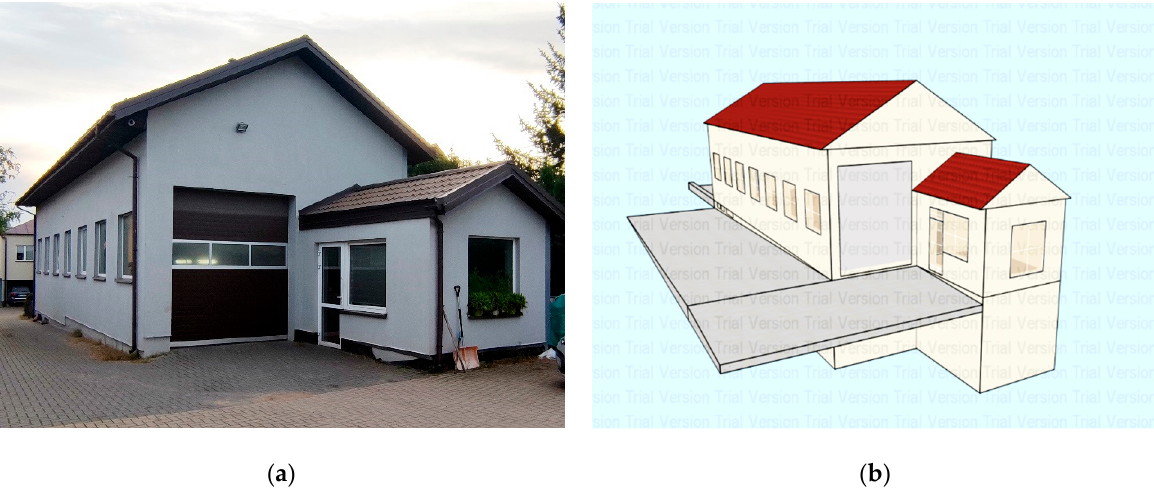
Figure 1. Analysed service building: ( a ) Photo of the building from the northeast and east elevations; ( b ) Visualization of the building created in DesignBuilder v7 software.